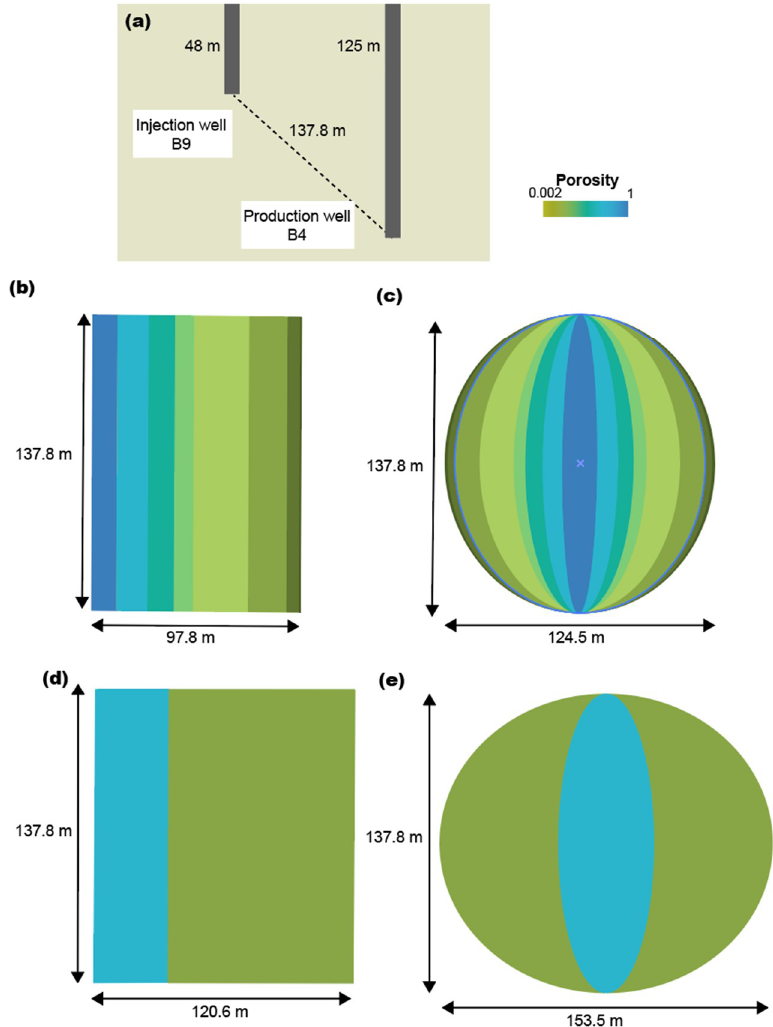
Figure 16. Estimated results of heat transfer area between well B4 and B9 in the Balcova geothermal field. ( a ) Schematic of well position, ( b , c ) estimated surface areas with nine flow paths, and ( d , e ) estimated surface area with two flow paths, assuming the area is ( b , d ) rectangular or ( c , e ) circle, respectively.